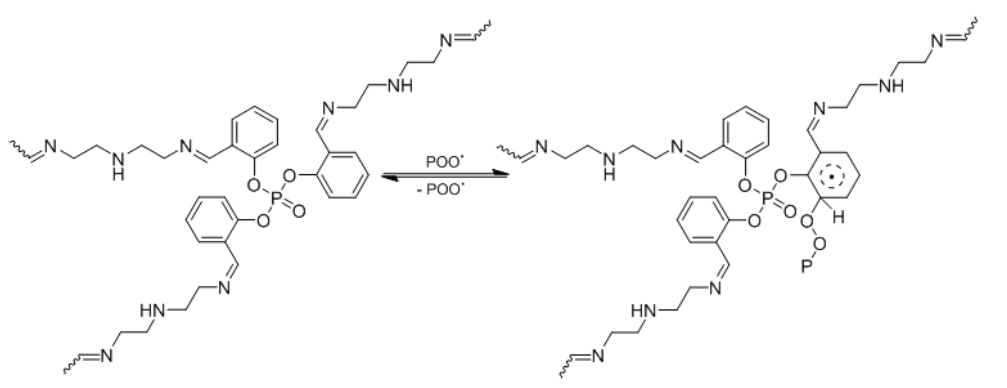
Figure 17. Polyphosphate 1 acts as a radical scavenger.